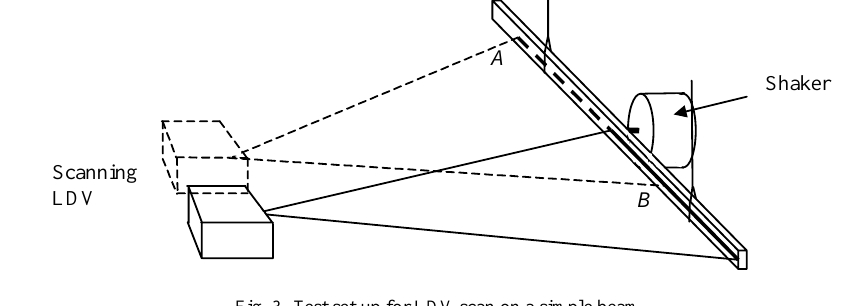
Fig. 3. Test set-up for LDV scan on a simple beam. Table 1 Half-beam scan CSLDV data, Mode